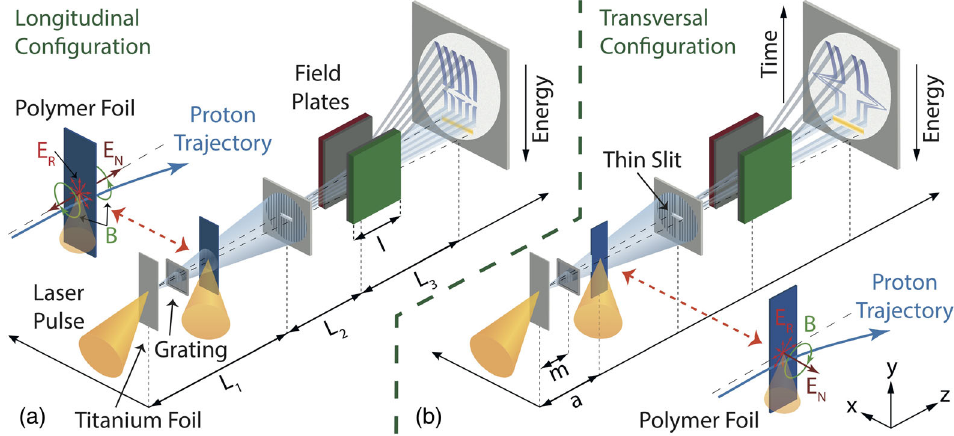
FIG. 2. Setup and imaging configurations: (a) longitudinal configuration, (b) transversal configuration.